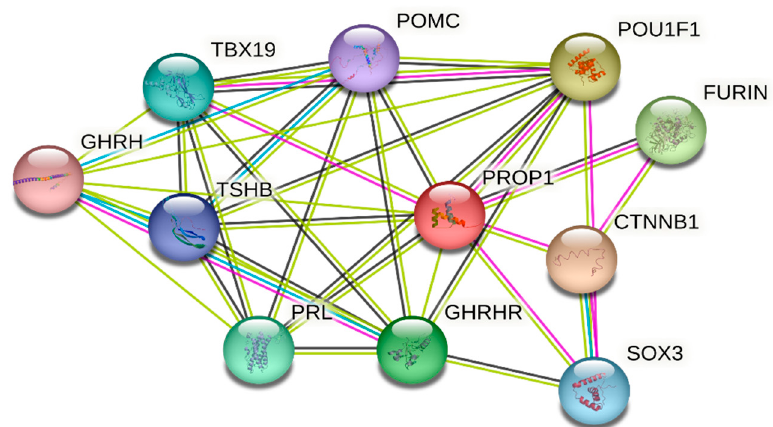
Figure 4. PROP1 protein–protein interaction network analysis using STRING database with confident sore 0.4. Strong association between PROP1 and other pituitary protein including thyroid-stimulating hormone POU1F1 and TSHB; short-stature-protein-associated POU1F1, GHRHR, SOX3, and CTNNB1; amenorrhea and infertility POU1F1 and SOX3 proteins.